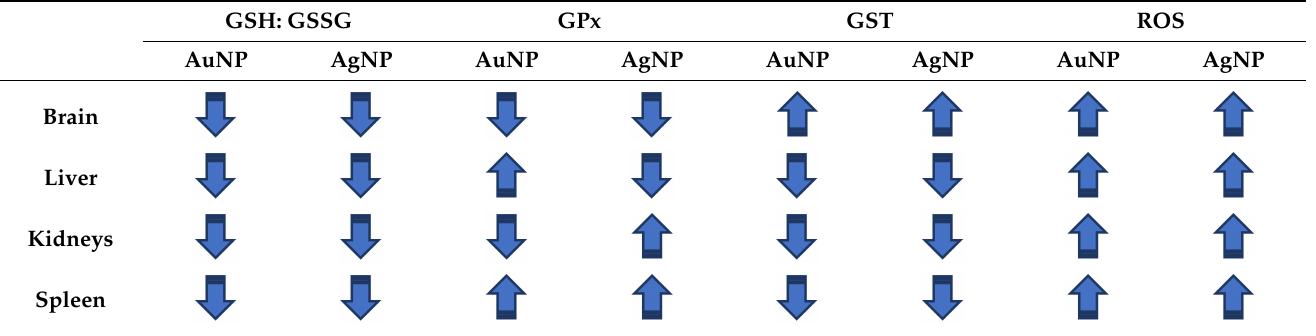
Table 4. The effect of gold and silver nanoparticles on soft tissues. GSH: GSSG—reduced glutathione: oxidized glutathione; GPx (glutathione peroxidase); ROS—reactive oxygen species; AuNP—gold nanoparticles; AgNP—silver nanoparticles; ↓ —decrease ↑ increase of